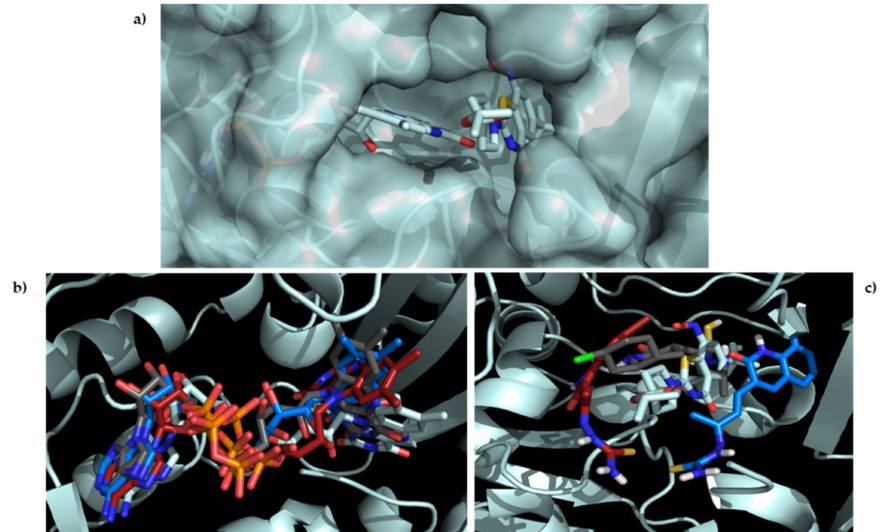
Figure 11. Experimental pose of FAD and BTZ043 in the experimental structure of ( a ) FAD ( b ) and ligands; ( c ) final pose after the 200 ns compared with DprE1. DprE1 and its ligands are presented in pale cyan, 11c in blue, 11d in gray, and 11e in red-pink.